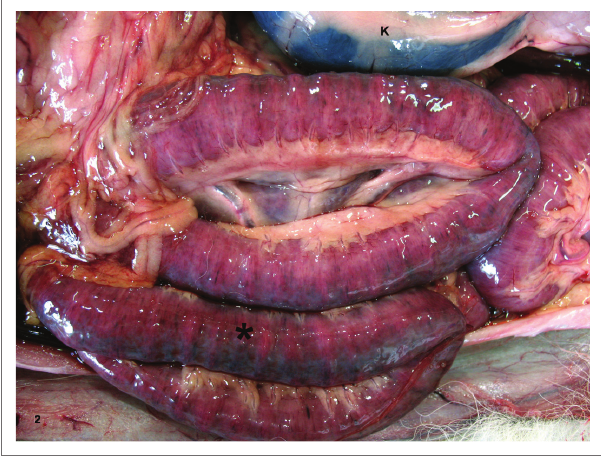
FIGURE 3: Feline panleukopaenia virus infection; intestine, cheetah, Case 9. Loss of intestinal crypt epithelial cells (arrows) is accompanied by mural haemorrhage ( * ) and bacterial colonies on the luminal surface (arrowheads).